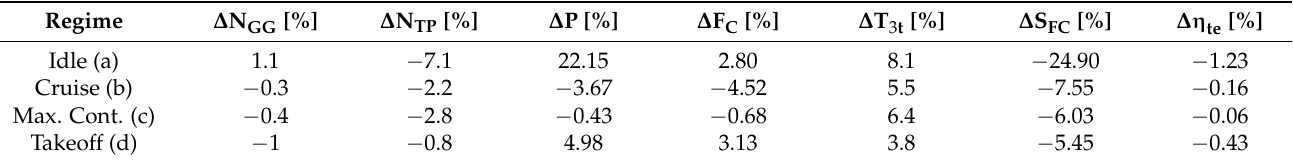
Table 10. Percentage differences of main engine parameters and